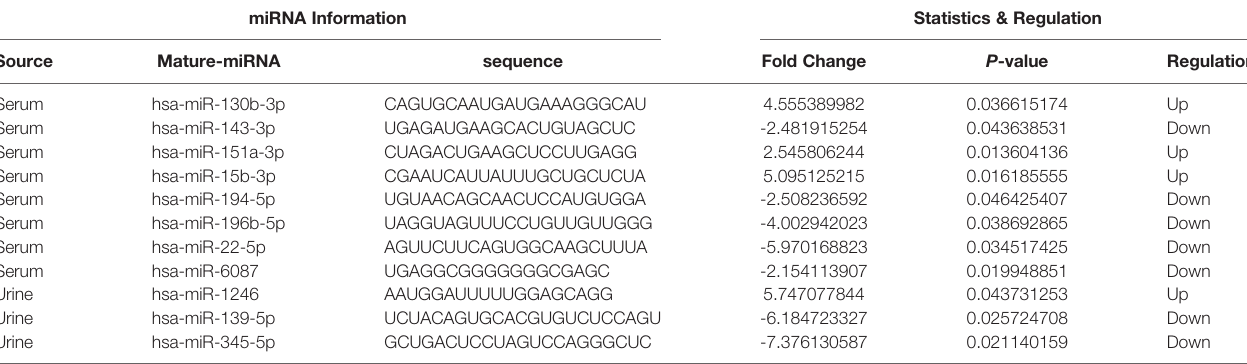
TABLE 1 | Differentially expressed exosomal microRNAs identi fi ed by next generation